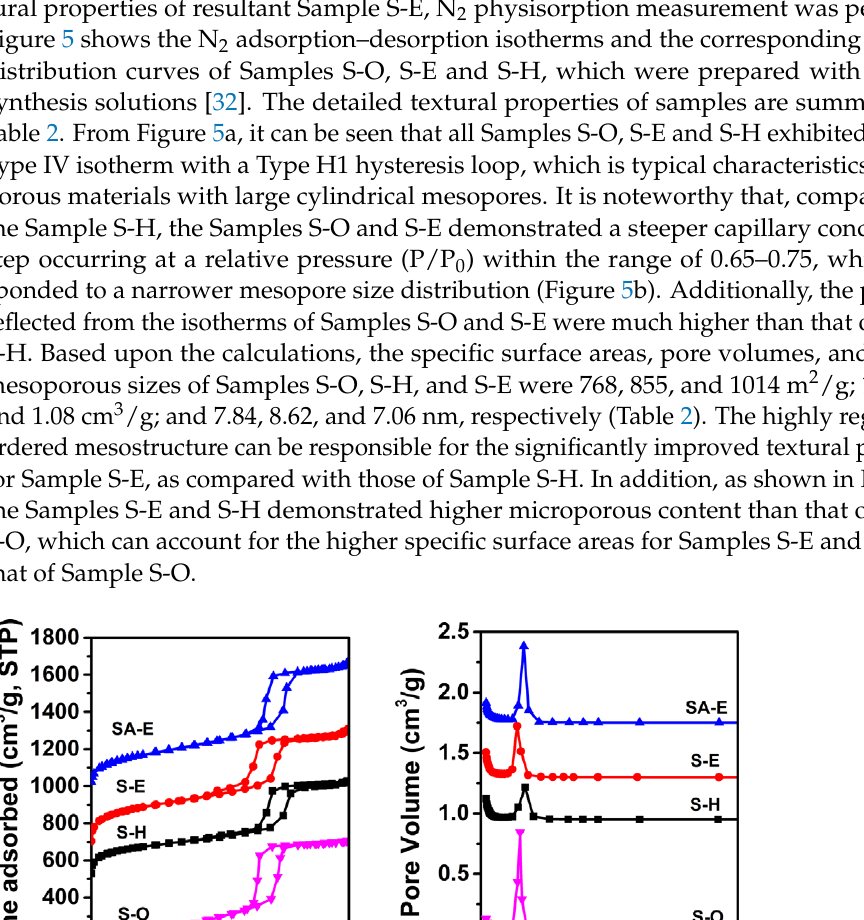
( d ) Figure 4. TEM images of Samples S - E ( a , b ) and SA - E ( c , d ) viewed along the [100] ( a , c ) and [110]